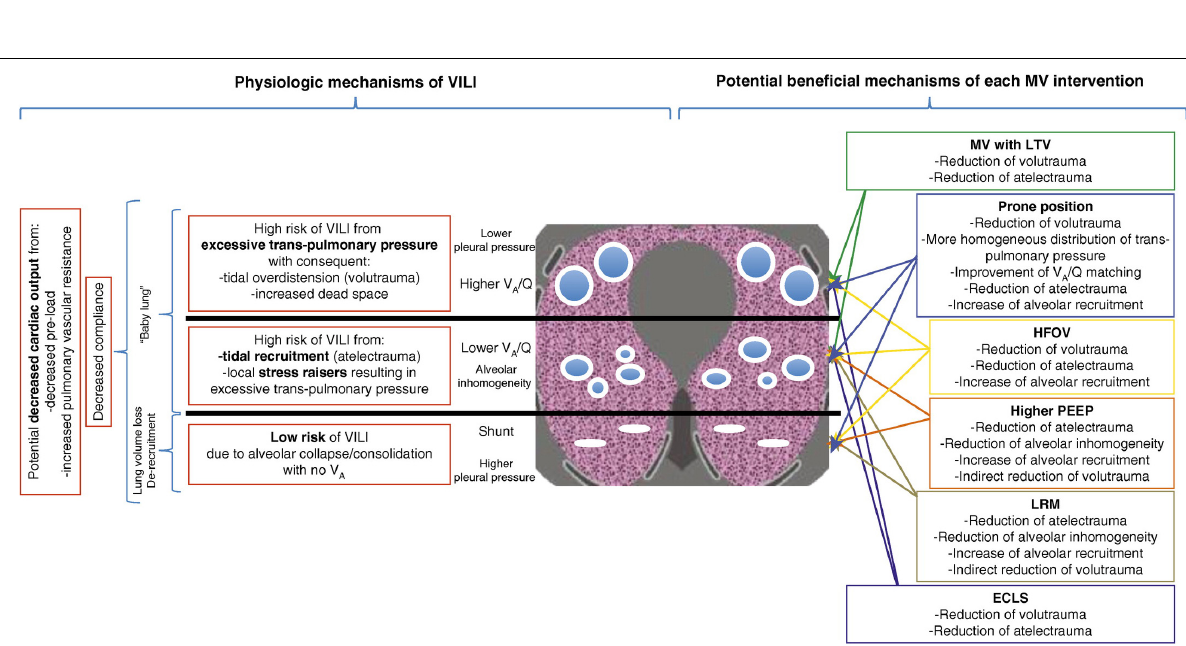
Frontiers in Physiology |